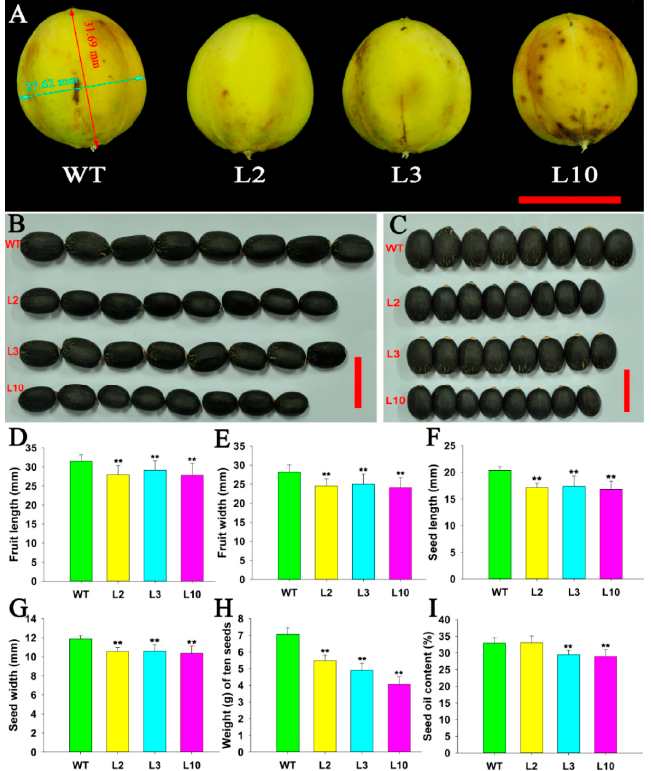
Figure 10. Decrease in the fruit size, seed size, seed weight, and seed oil content in the JcDAD1 -RNAi transgenic plants. ( A ) Fruits from the wild type (WT) and transgenic Jatropha plants. The red line with the double-headed arrow represents the fruit length (31.69 mm), and the cyan line represents the fruit width (27.62 mm). ( B , C ) Seed length and width in the WT and transgenic Jatropha plants. ( D , E ) Fruit length and width in the WT and transgenic Jatropha plants, n ≥ 34. ( F , G ) Seed length and width in the WT and transgenic Jatropha plants, n ≥ 120. ( H ) Ten-seed weight in the WT and transgenic Jatropha plants, n ≥ 14. ( I ) Seed oil content in the WT and transgenic Jatropha plants, n ≥ 14. Scale bars = 2.0 cm. L2, L3 and L10 represent di ff erent transgenic lines. Error bars represent standard deviations. Student’s t -test was performed to analyze significant di ff erences. ** Extremely significant di ff erence ( p <